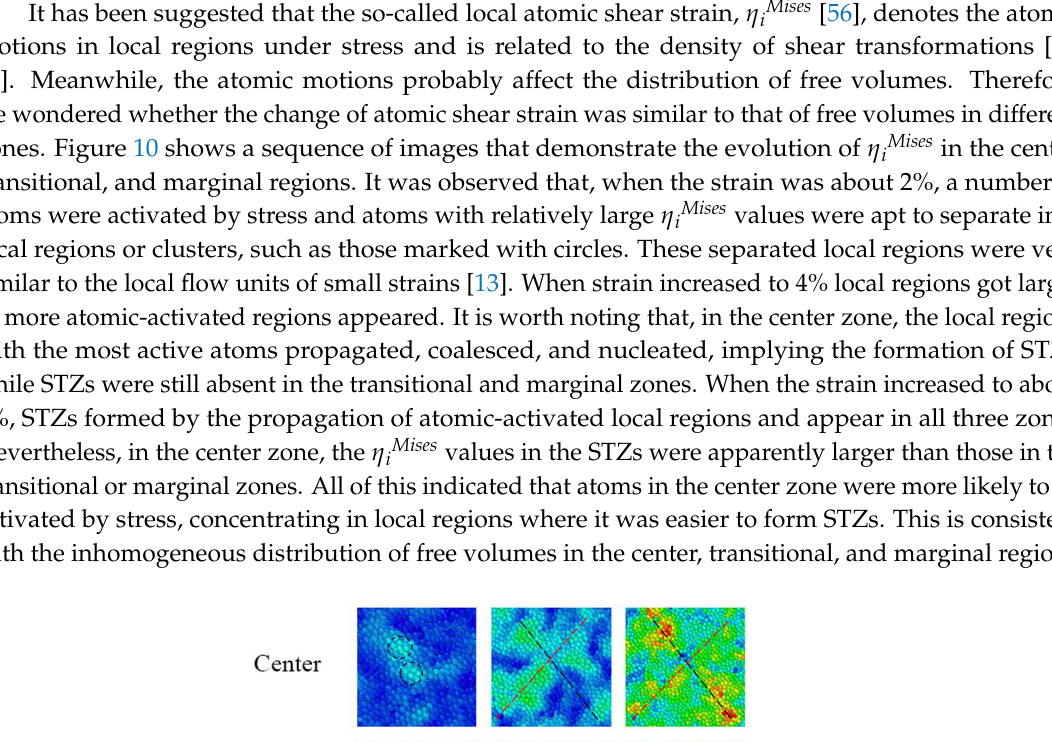
Figure 9. The distribution of free volumes in a local region (5 × 5 × 5 Å 3 ) of the center zone at the strains of ( a ) 0% and ( b ) 4%. The gray and the red spheres denote free volumes with relatively small (0.4–0.8 Å ) and large (>0.8 Å ) sizes, respectively.